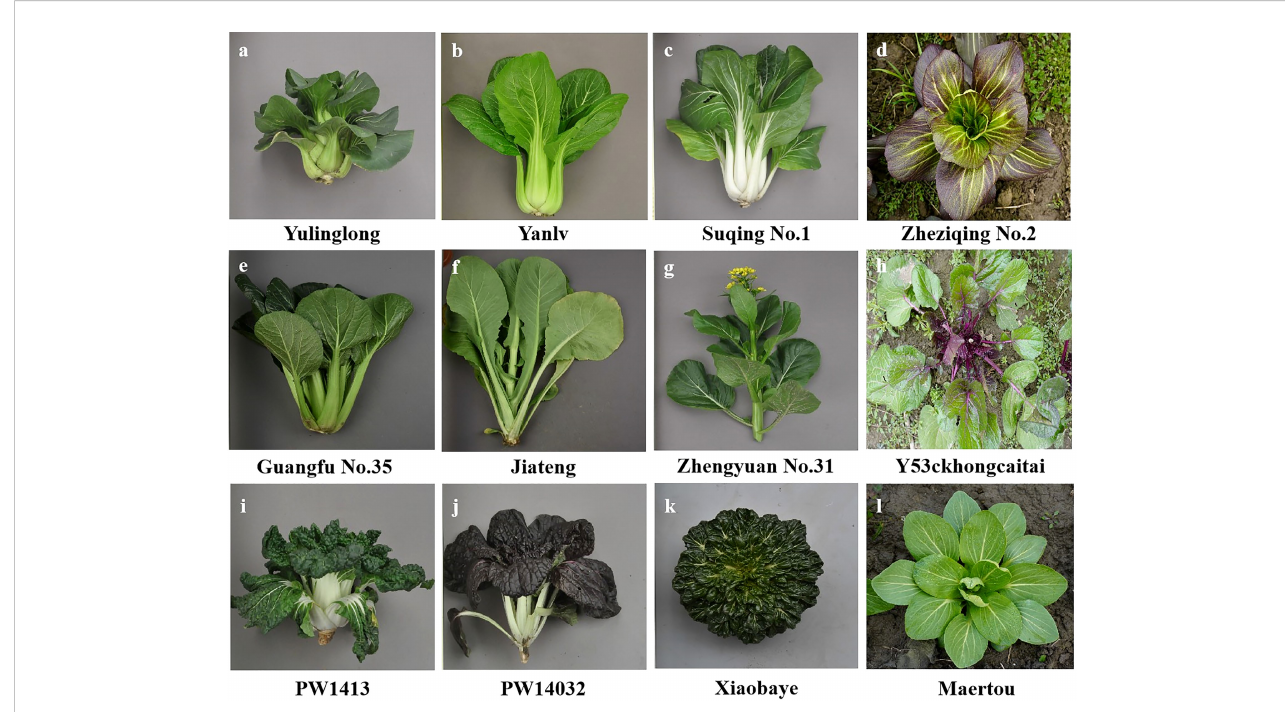
TABLE 1 Details of morphological characteristics investigated in 423 non-heading Chinese cabbage varieties.